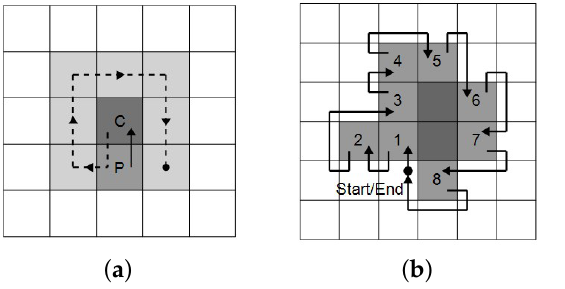
Figure 5. Example depiction of Moore-Neighbor boundary tracing. ( a ) Moore-Neighborhood of pixel C, and prior boundary pixel P. ( b ) Tracing of a pixel cluster by stepping through pixels 1–8. Through the detection of the boundary of an area of interest (e.g., the braid) within an image realized, analysis of the size and shape of the boundary can then commence as